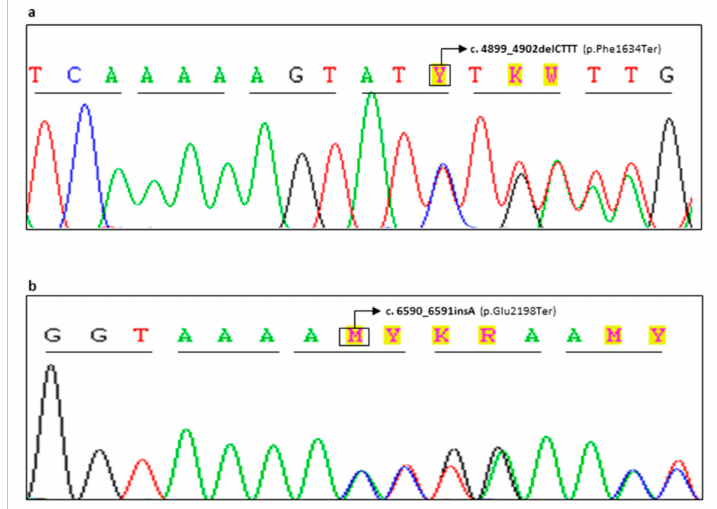
Figure 3. Two novel deleterious variants detected in BRCA2 gene. ( a ) Electropherogram showing the BRCA2 c.4899_4902delCTTT variant causing a stop codon at 1634 position within exon 11. ( b ) Electropherogram showing the BRCA2 c.6590_6591insA variant causing a stop codon at 2198 position within exon